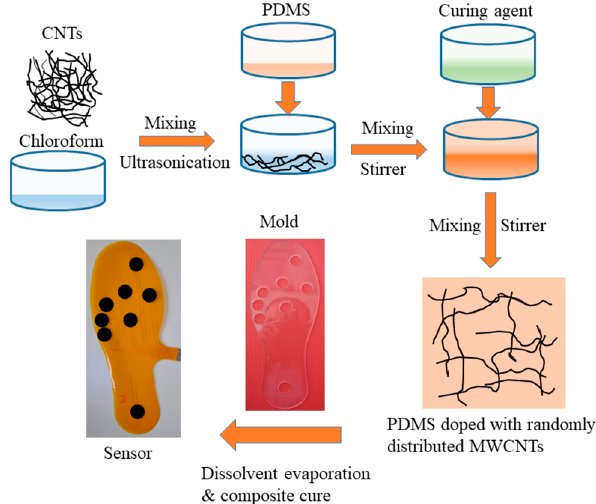
Figure 1. Schematic of the processing procedure for preparing a multiwall carbon nanotubes (MWCNTs)/polydimethylsiloxane (PDMS) conductive elastomer and fabricating the plantar pressure sensor.